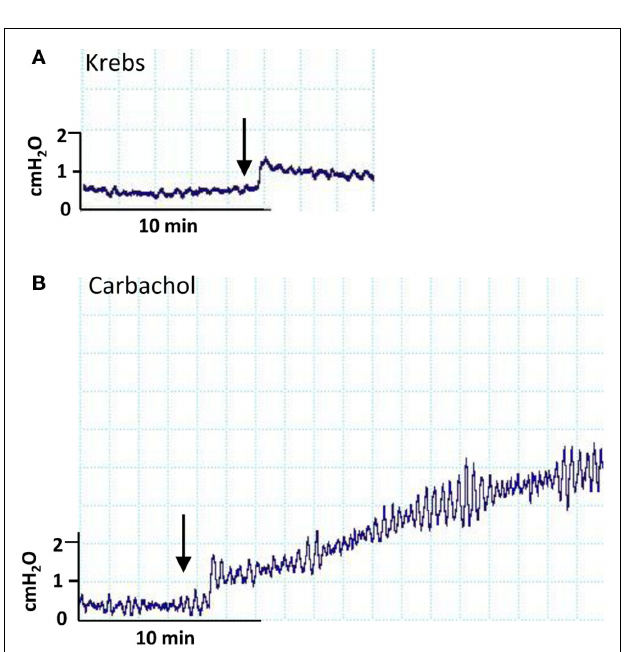
FIGURE 2 | Pressure traces from an isolated whole pig bladder following administration of increasing concentrations of carbachol (arrows) through the arterial route: (A) intravesical pressure and (B) arterial